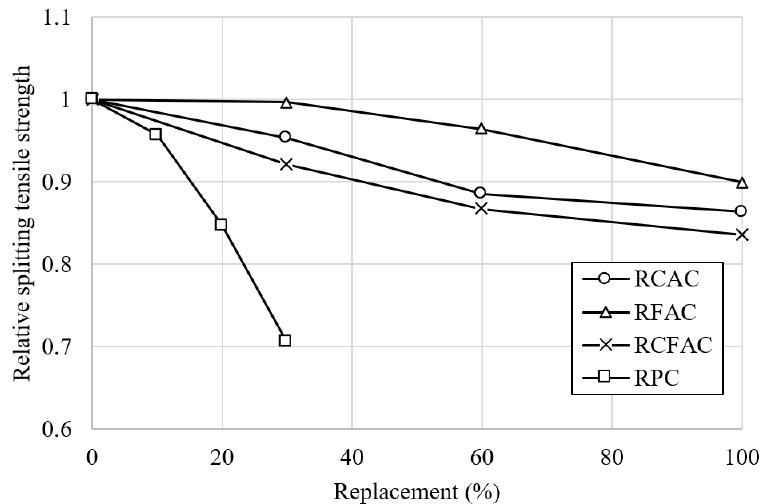
Figure 7. Relative splitting tensile strength of various concretes by replacement ratio.